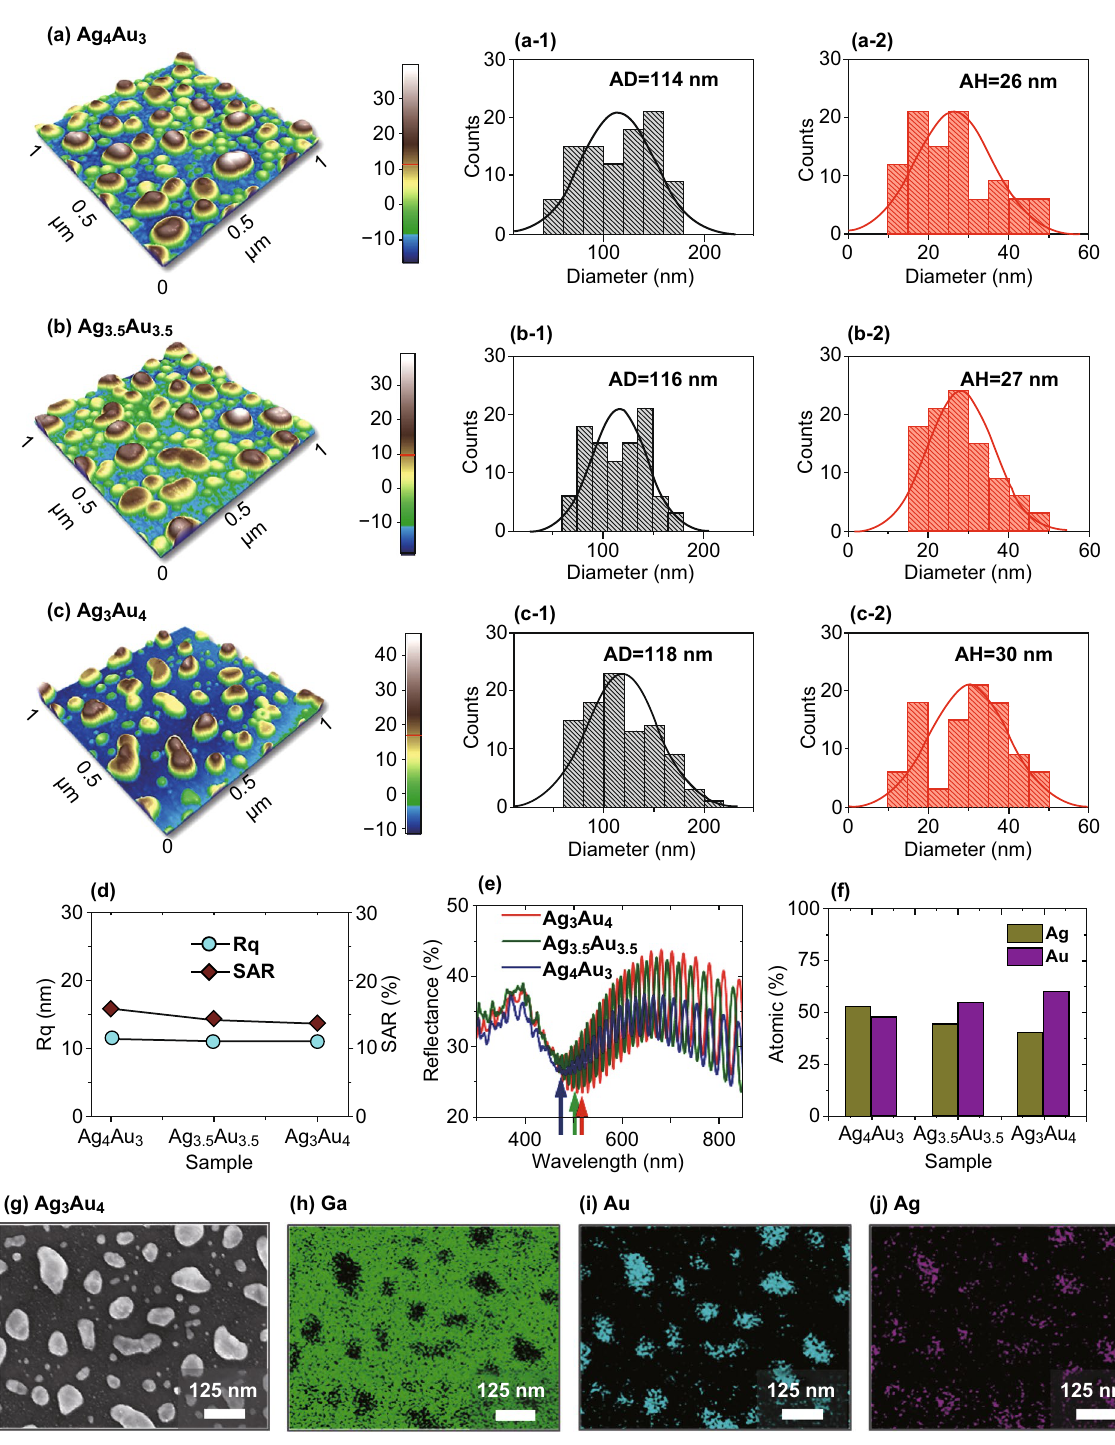
Fig. 4 Surface morphology of AgAu alloy NPs fabricated on bare GaN with various thickness ratio of Ag and Au in the Ag x nm Au y nm bilayers. a – c AFM images of the alloy NPs with the Ag 4 Au 3 , Ag 3.5 Au 3.5 and Ag 3 Au 4 bilayers on GaN . a-1 – c-1 Corresponding diameter distribution his‑ tograms of alloy NPs. a-2 – c-2 Height distribution histograms. d Summary plots of R q and SAR . e Reflectance spectra. f Summary of the atomic percentage of Ag and Au with various thickness ratio. g – j SEM image and corresponding elemental maps of Ga, Au, and Ag for the alloy NPs fabricated with the